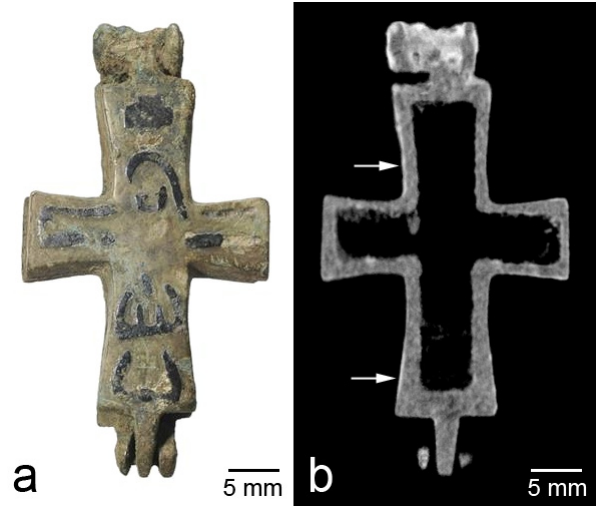
Figure 1. Photograph ( a ) and tomographic slice ( b ) of the cross from Fedosyino-1; arrows show areas of surface corrosion.